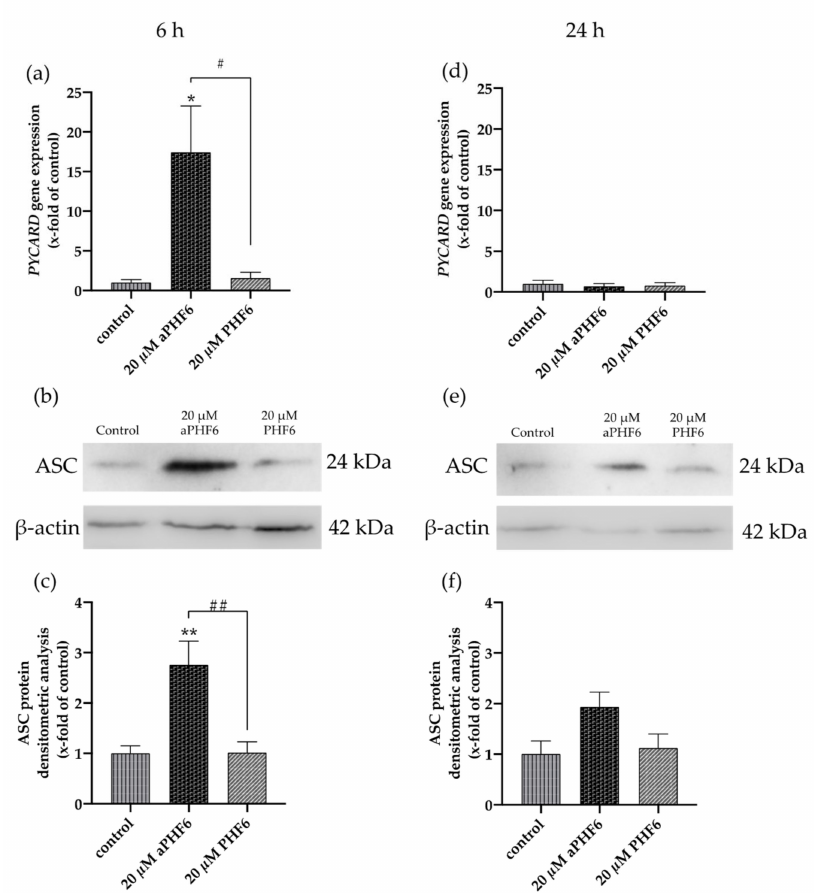
Figure 4. Aggregated PHF6 induced upregulation in PYCARD mRNA and ASC protein in HMC3 cells after 6 h. ( a ) An increase in the mRNA levels of PYCARD ( ASC ) is observed after treatment with 20 µ M aPHF6 in comparison to the PHF6 or untreated controls as quantified by qRT-PCR. ( b , c ) Densitometric analysis of Western blots confirmed the increased ASC protein levels at 6 h. ( d ) No changes in PYCARD ( ASC ) mRNA levels among different groups were detected after 24 h. ( e , f ) However, Western blot analysis reflects a non-significant increase in ASC protein levels in the aPHF6 group compared to the controls. */# p < 0.05, **/## p <